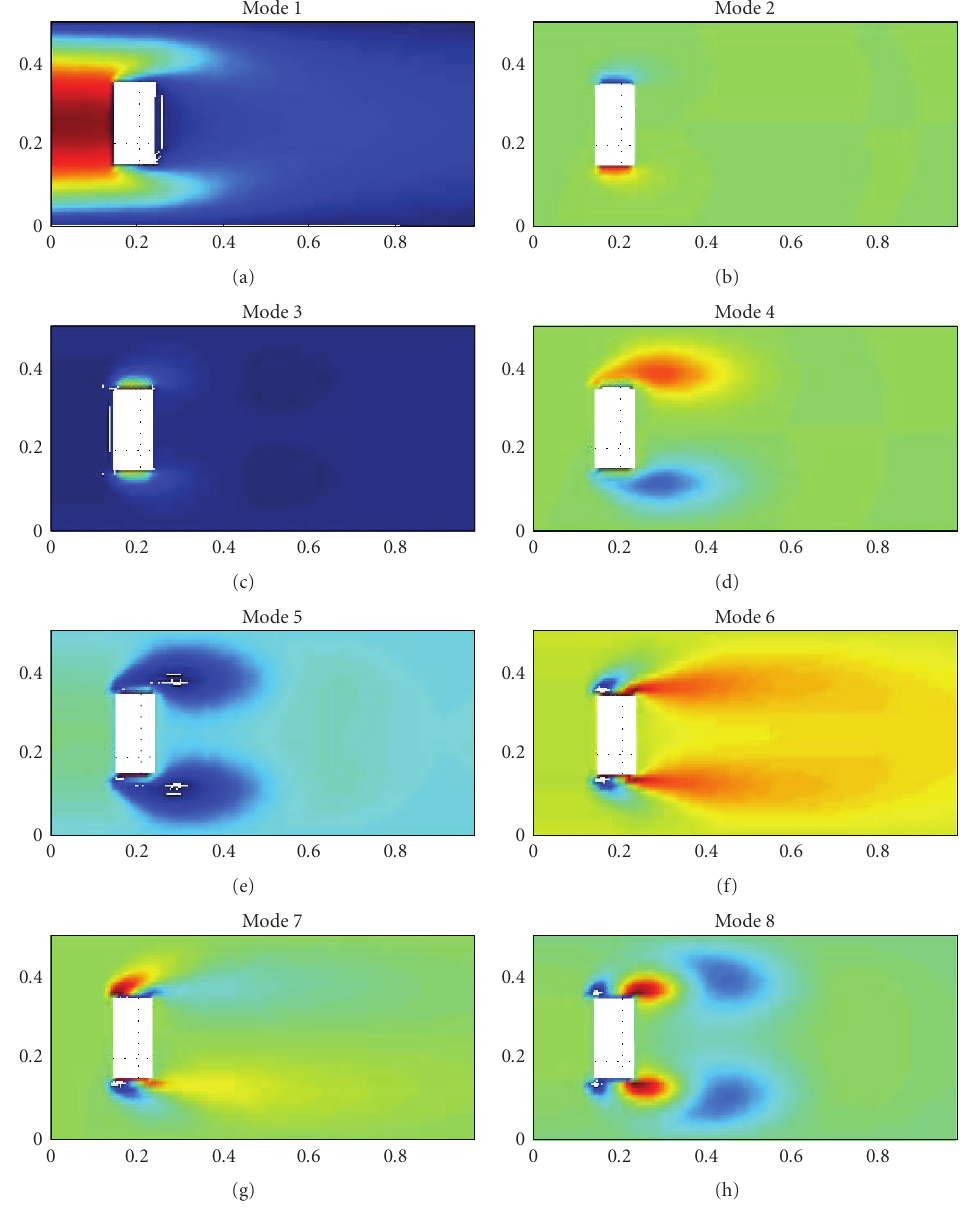
Figure 3: First eight POD